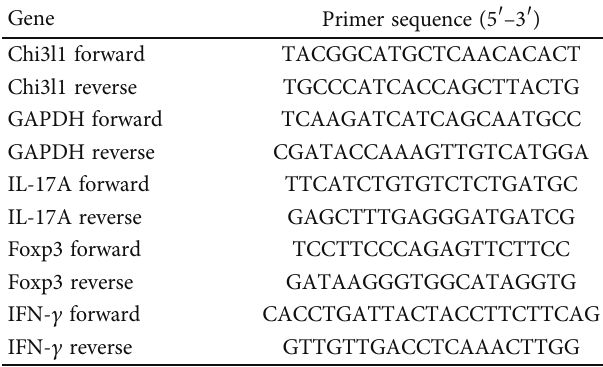
Table 1: Primer sequences. Gene Primer sequence (5 ′ – 3 ′